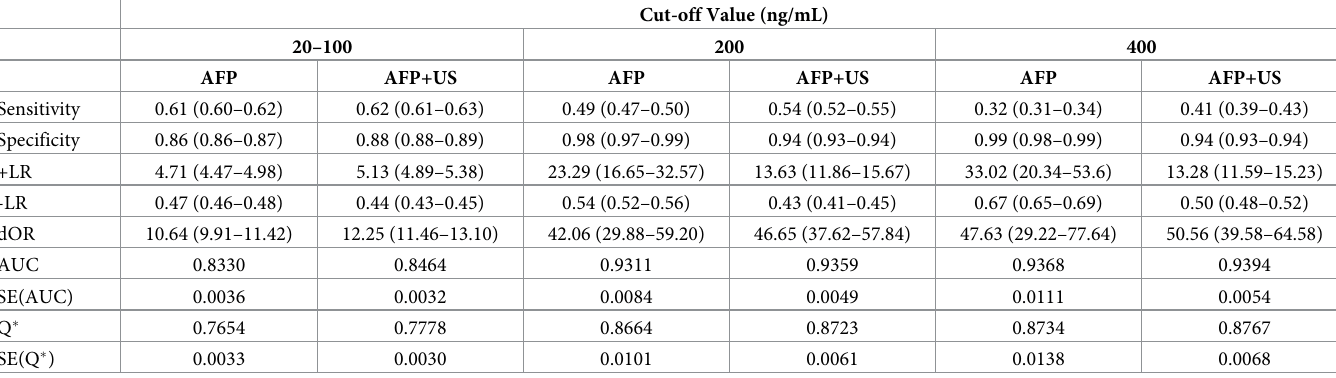
Table 3. Diagnostic accuracy estimates based on varied thresholds of